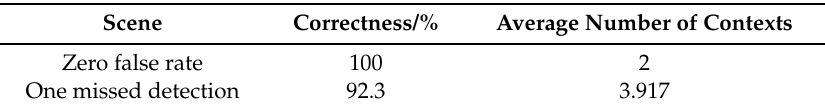
Table 4. The results with different false rate.